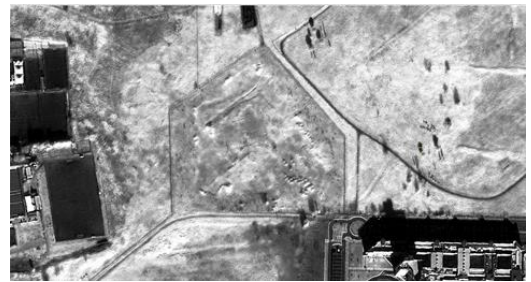
Figure 11. NIR in B/W mode, detail of Villa Ad Duas Lauros